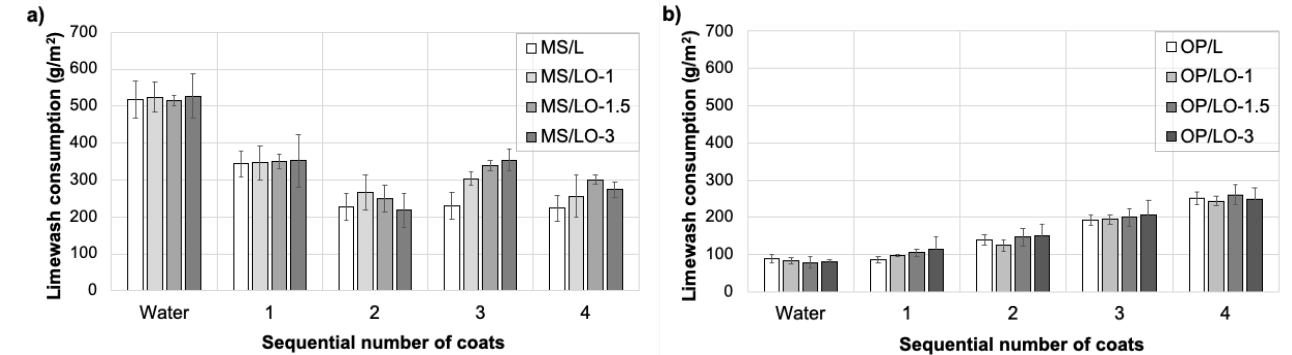
Figure 1. Limewash uptake between coats: ( a ) Mšené, ( b ) Opuka. Note: the samples are wetted with water just before applying coat no.1; coats nos. 1 and 2 correspond to pure limewash (L) in all specimens.